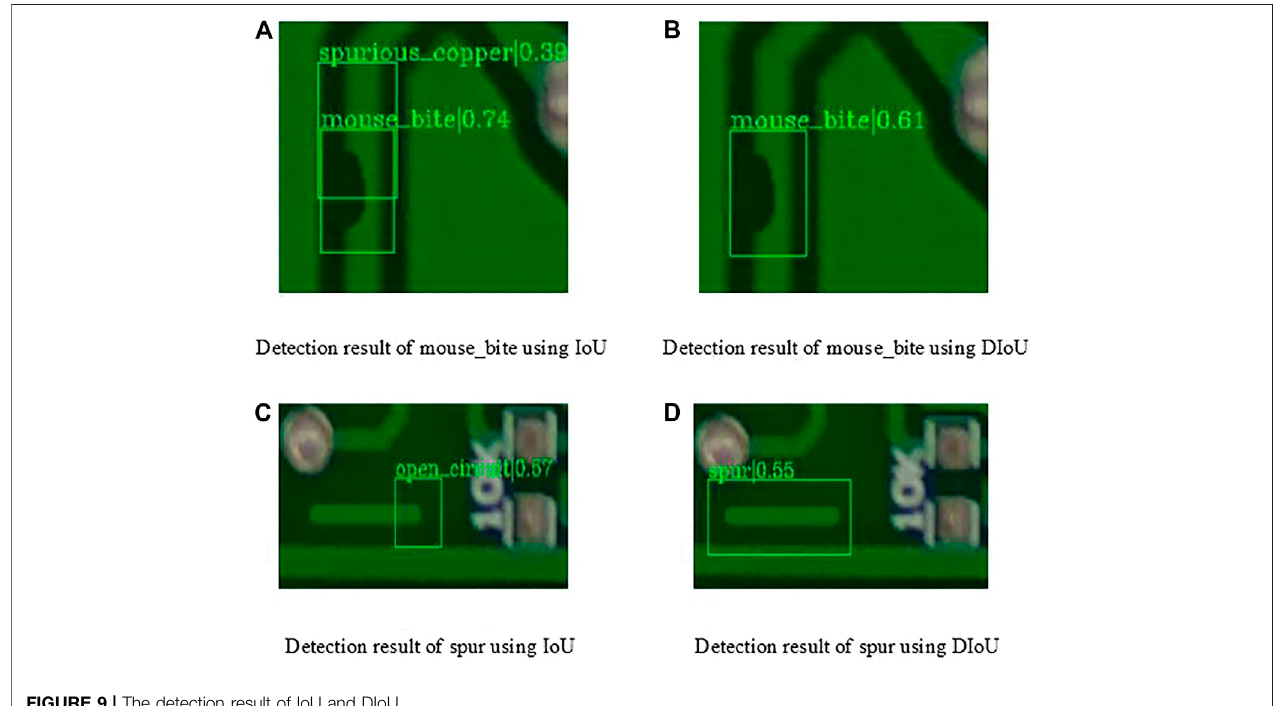
FIGURE 9 | The detection result of IoU and DIoU.